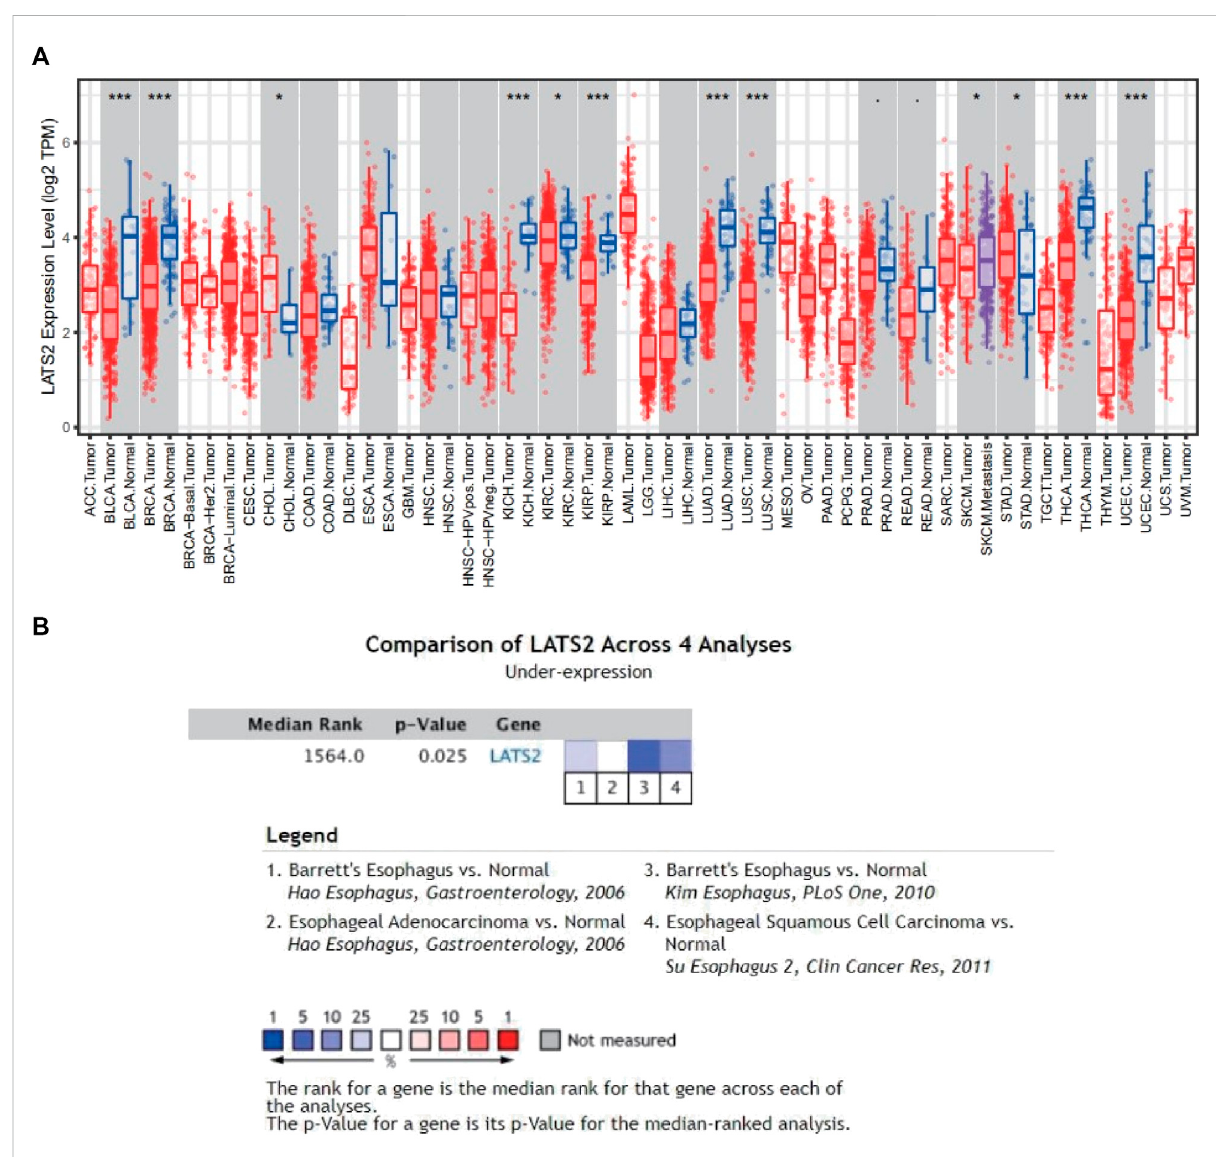
FIGURE 1 (A) Pan-canceranalysisexpressionofLATS2basedontheTIMER1.0database. (B) Meta-analysisexpressionofLATS2inESCCintheONCOMINE